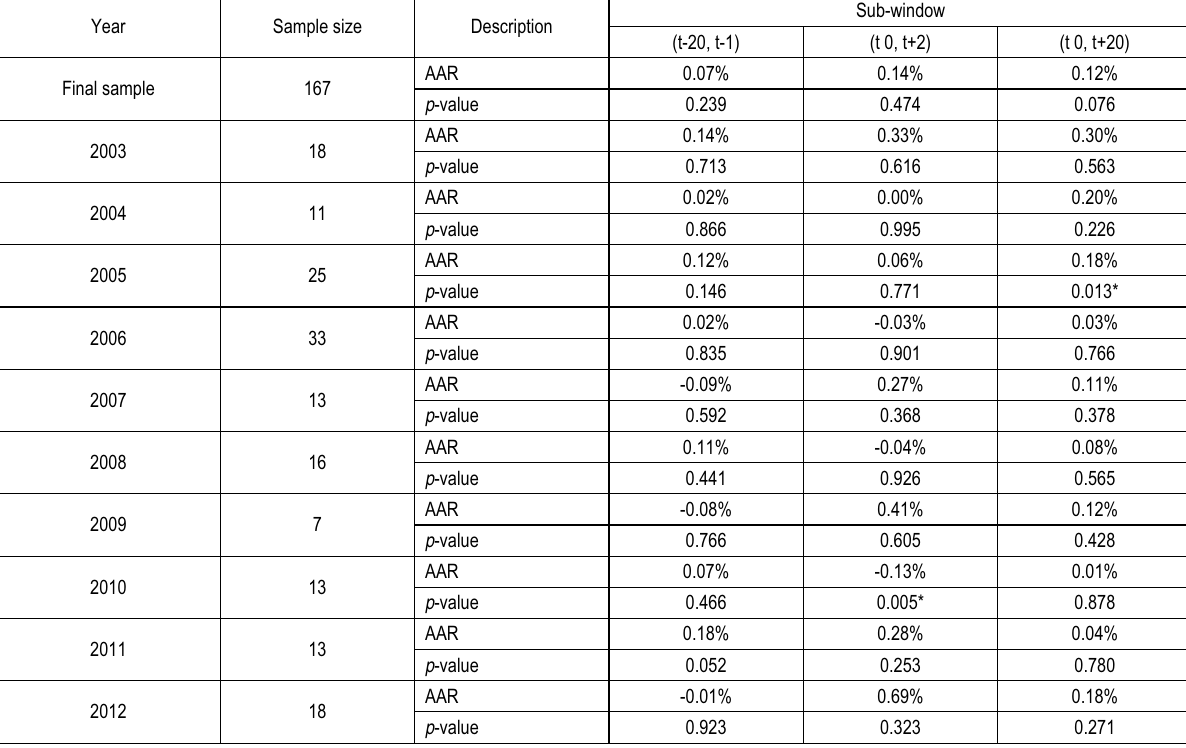
Table 8. Abnormal share price performance surrounding the event day by sub-window and calendar